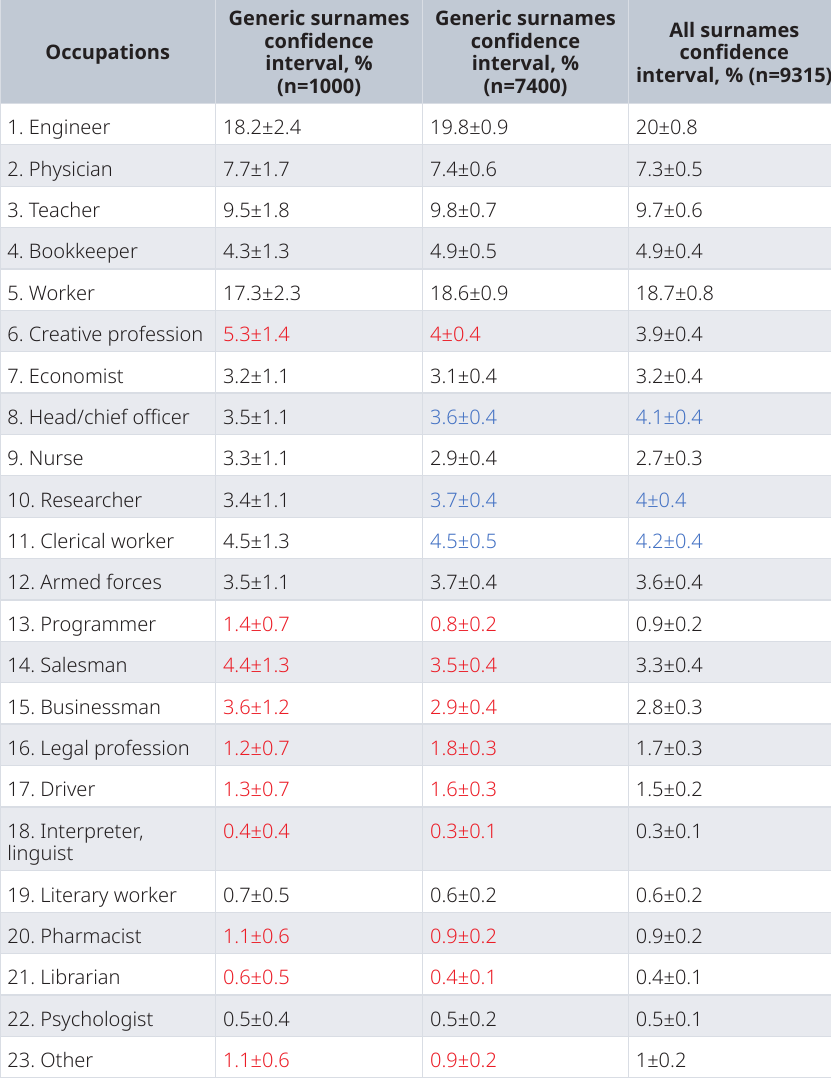
Table 5. Occupational distribution of generic and all surnames. The third column provides population means together with the confidence interval as derived from the full pool of 7400 individuals. For comparison with other surnames’ classes, we present in the second column also the distribution that would be derived by using only the first 1000